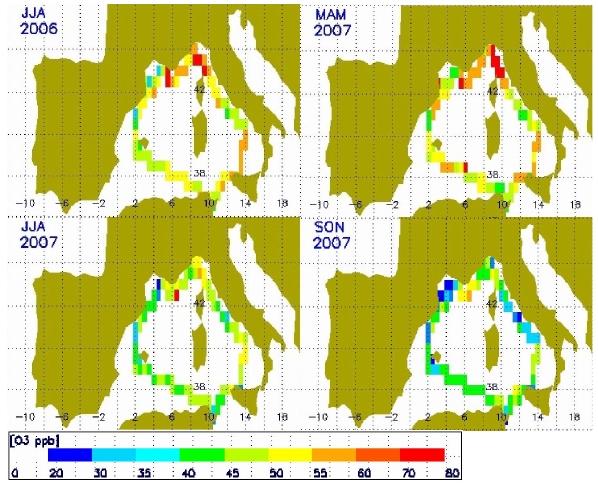
Fig. 5. Plots of averaged measured concentrations of ozone during the summer (June, July August) for the year 2006 and summer, spring (March, April May) and autumn (September, October, November) for 2007. The data have been filtered as described above.